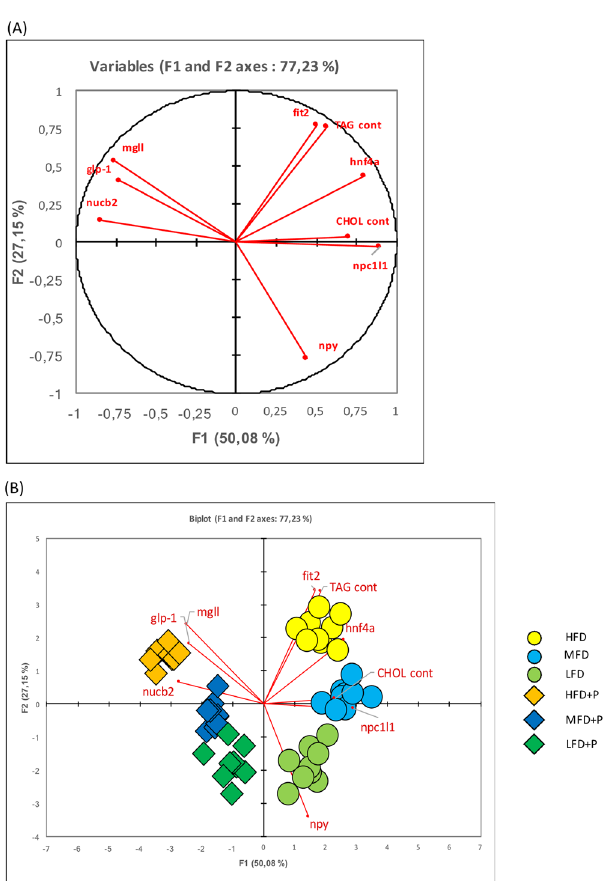
Figure 8. PCA analysis. ( A ) Plot showing how the selected variable correlate with F1 and F2 axes, which were found by the PCA as the two components which best discriminates among groups. ( B ) Plot showing the added observations, which are divided by colours and